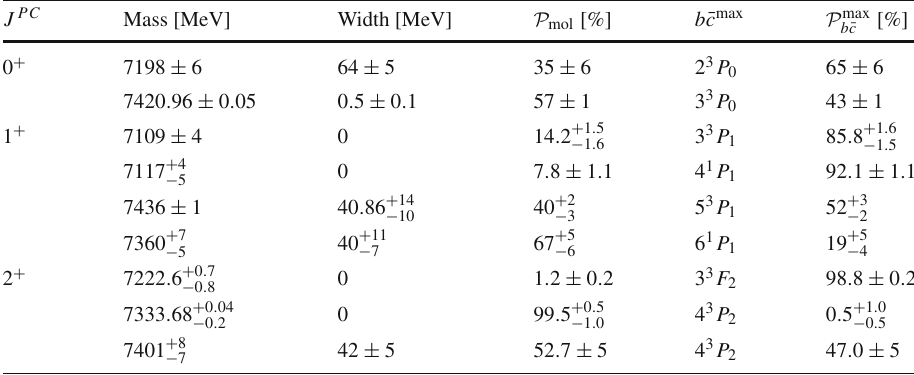
Table 4 Additional and dressed b ¯ c states. P max denotes the b ¯ c probability of the dominant b ¯ c max state. Theoretical error estimated from the uncertainty of the vertex parameter: γ = 0 . 247 ± 0 .